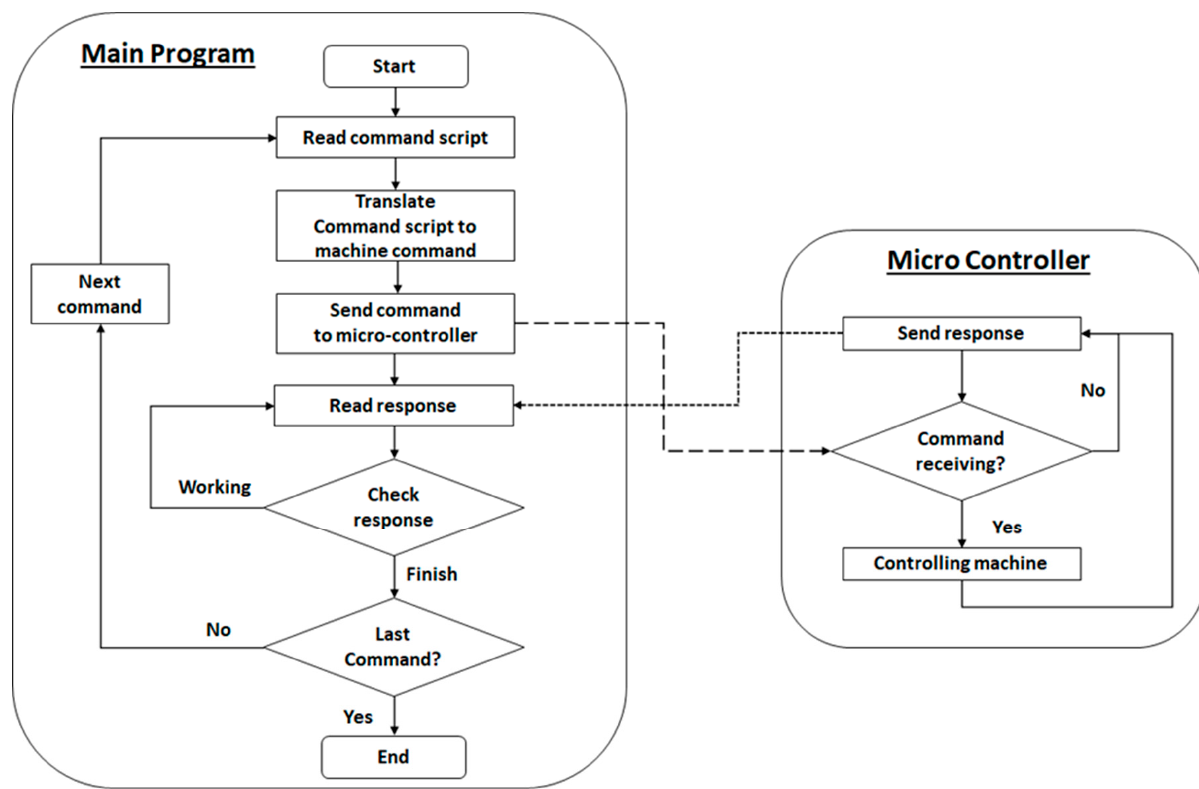
Figure 5. On-line pH monitoring system. ( a ) a CAD file of a pH sensor; ( b ) a photo of a pH sensor with green LED.